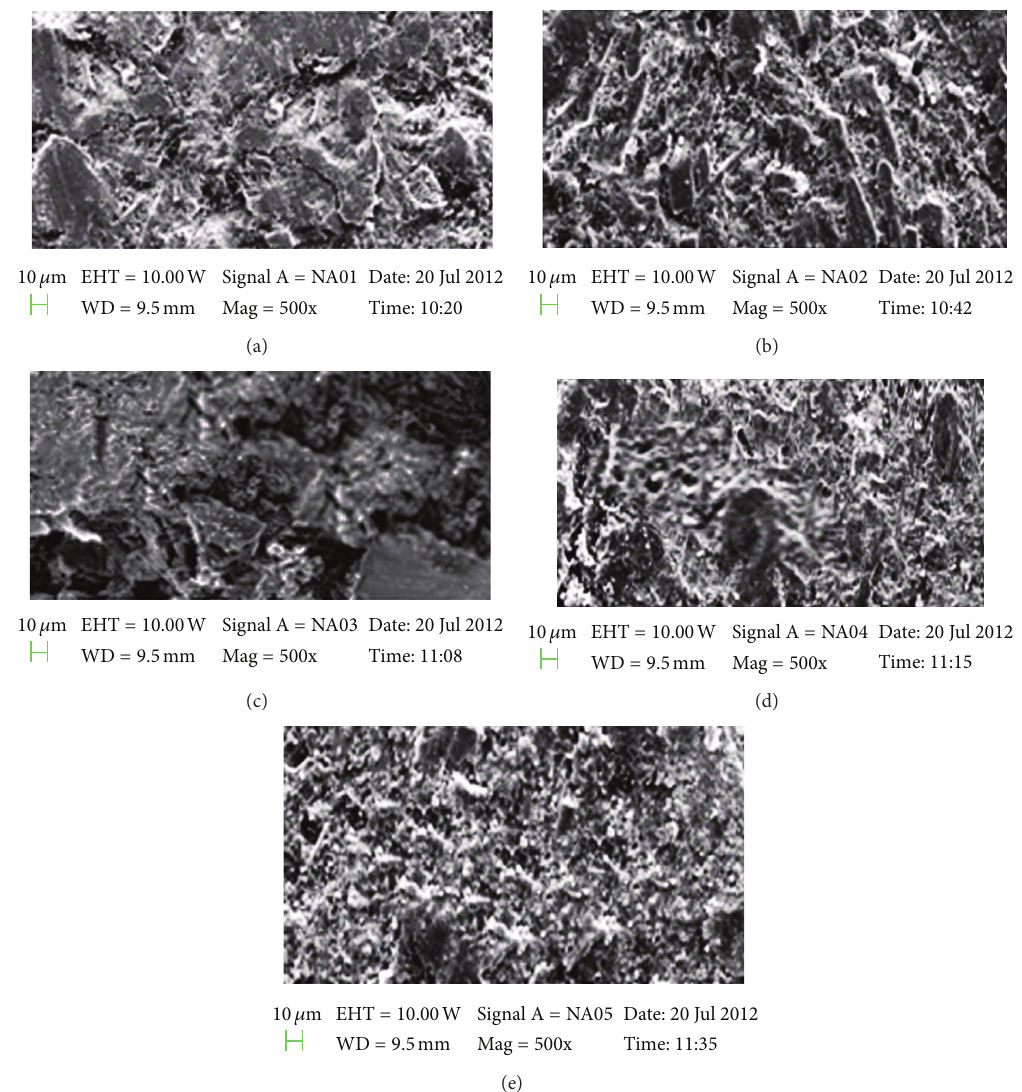
Figure 13: (a) SEM of Na01 at 500x. (b) SEM of Na02 at 500x. (c) SEM of Na03 at 500x. (d) SEM of Na04 at 500x. (e) SEM of Na05 at